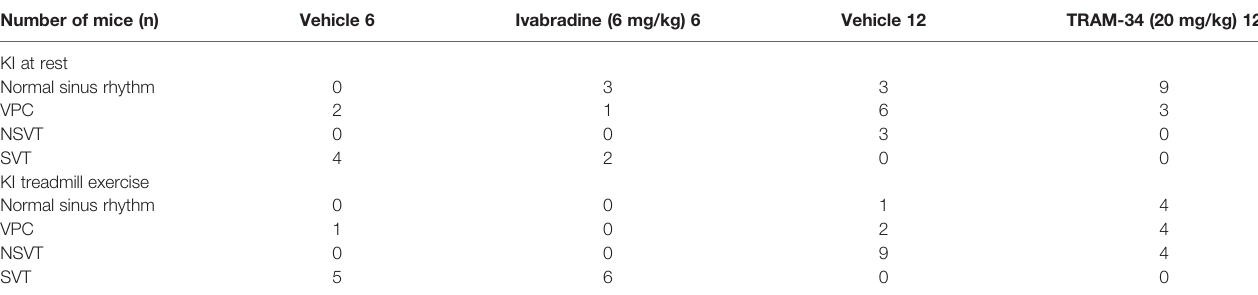
TABLE 1 | Comparative effects of ivabradine and TRAM-34 on the arrhythmogenic features of CPVT2 CASQ2-D307H knock-in (KI) mice at rest or during treadmill exercise. Number of mice